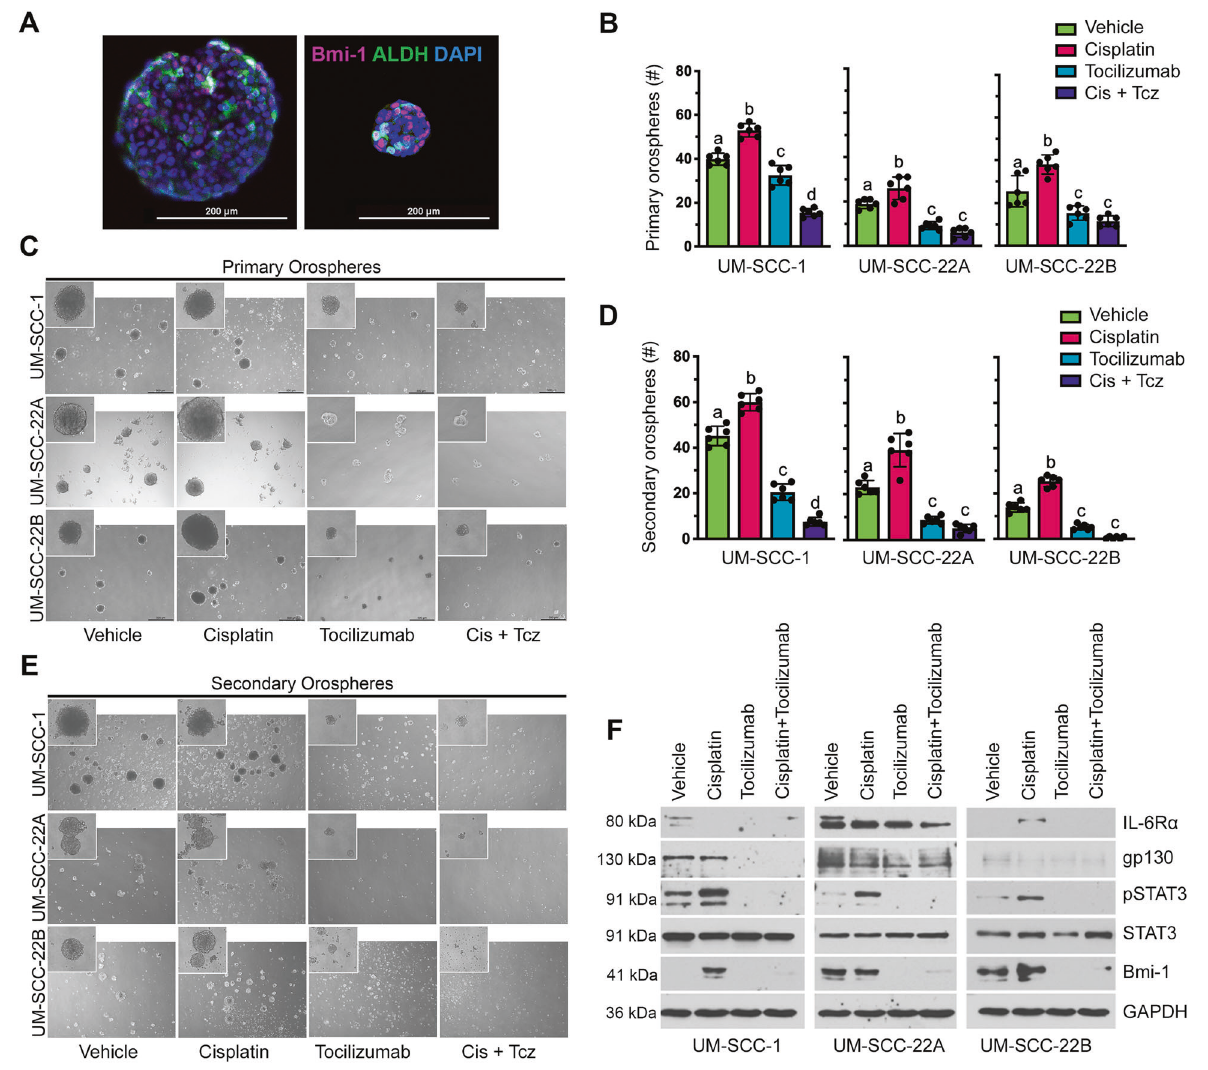
Fig. 4 Tocilizumab prevents Cisplatin-induced self-renewal of cells in orospheres. A Representative images of immuno fl uorescence staining of untreated, cryosectioned orospheres after 8 days in suspension culture. Example images of both a large (left) and small (right) orosphere are shown. B Bar graphs depicting the mean number ± SD of primary orospheres per well ( n = 6 per treatment group). Different lowercase letters indicate statistical signi fi cance at p < 0.05. C Representative images (×40) of primary orospheres 8 days after treatment with Cisplatin (1 µm) and/or Tocilizumab (0.1 µm). Cells were treated the day after seeding in ultra-low attachment plates. Inserts at ×100 magni fi cation. D Bar graphs depicting the mean number ± SD of secondary orospheres per well ( n = 6 per treatment group). Different lowercase letters indicate statistical signi fi cance at p < 0.05. E Representative images (×40) of secondary orospheres on day 8 after treatment with Cisplatin (1 µM) and/or Tocilizumab (0.1 µM). Cells were treated the day after seeding in ultra-low attachment plates. Inserts at ×100 magni fi cation. F Western blottings showing protein levels Bmi-1, IL-6R, gp130, pSTAT3, and STAT3 in lysates prepared from primary orospheres on day 8 after treatment with Cisplatin (1 µM) and/or Tocilizumab (0.1